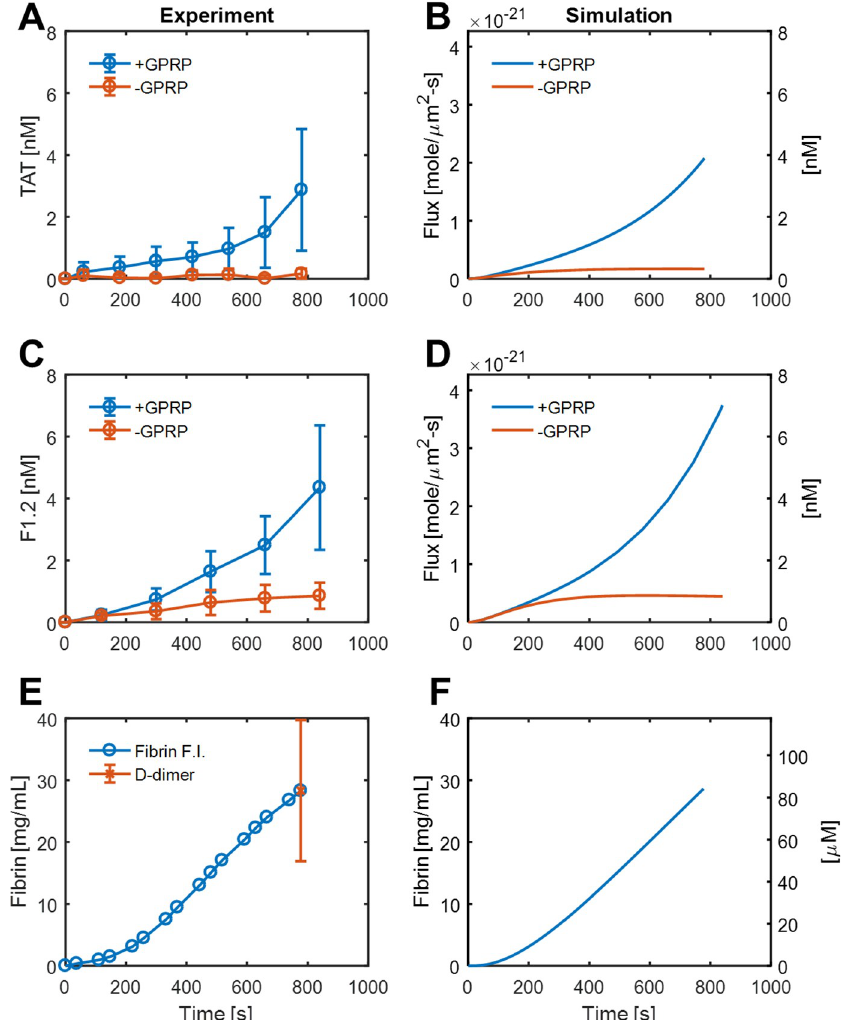
Fig 2. Comparison of experiment and simulation for TAT, F1.2, and fibrin dynamics. Thrombin-antithrombin (TAT) and Fragment F1.2 elution from clots in the presence or absence of fibrin ( ± GPRP) for experimental perfusion of whole blood over collagen/TF (A,C) and in simulations under identical conditions (B, D). Fibrin was measured dynamically by fluorescent fibrinogen incorporation and then calibrated by end-point D-dimer assay following plasmin degradation (E), while the intrathrombus fibrin concentration was simulated (F).